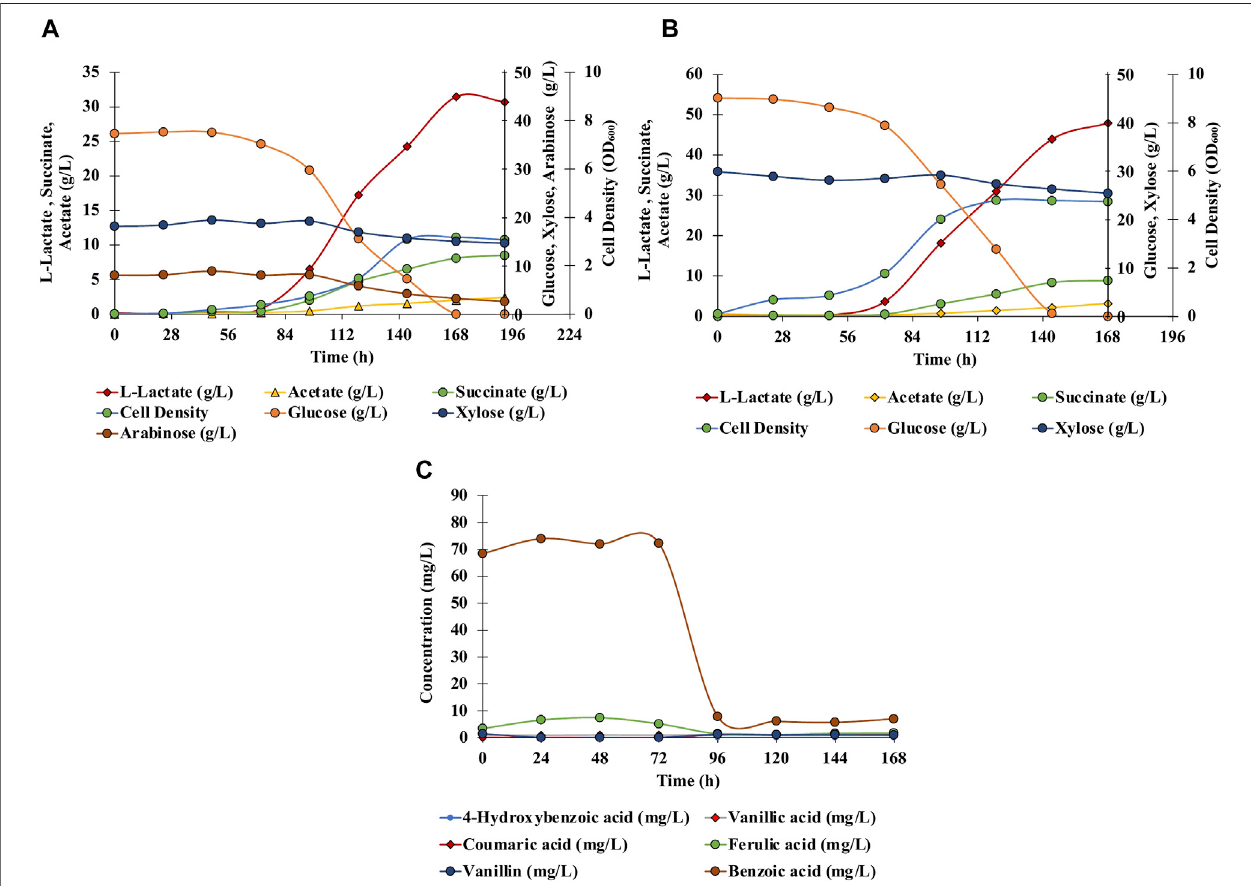
FIGURE6| Effectofdifferentfermentationcultivationparametersonmixed-acidsproductionby C.glutamicum. Dataisshownforsinglefedbatchfermentation. (A) Anaerobic, batch, pH 7, BTM2 supplemented with glucose, xylose, and arabinose; (B) Anaerobic, batch, pH 7, DMR hydrolysate; (C) Aromatics utilization: anaerobic, batch, pH 7, DMR